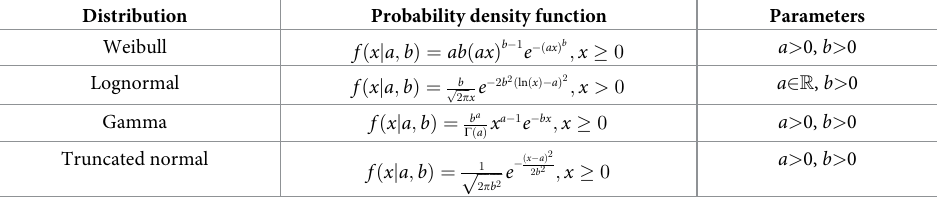
Table 1. Distributions used to estimate the serial